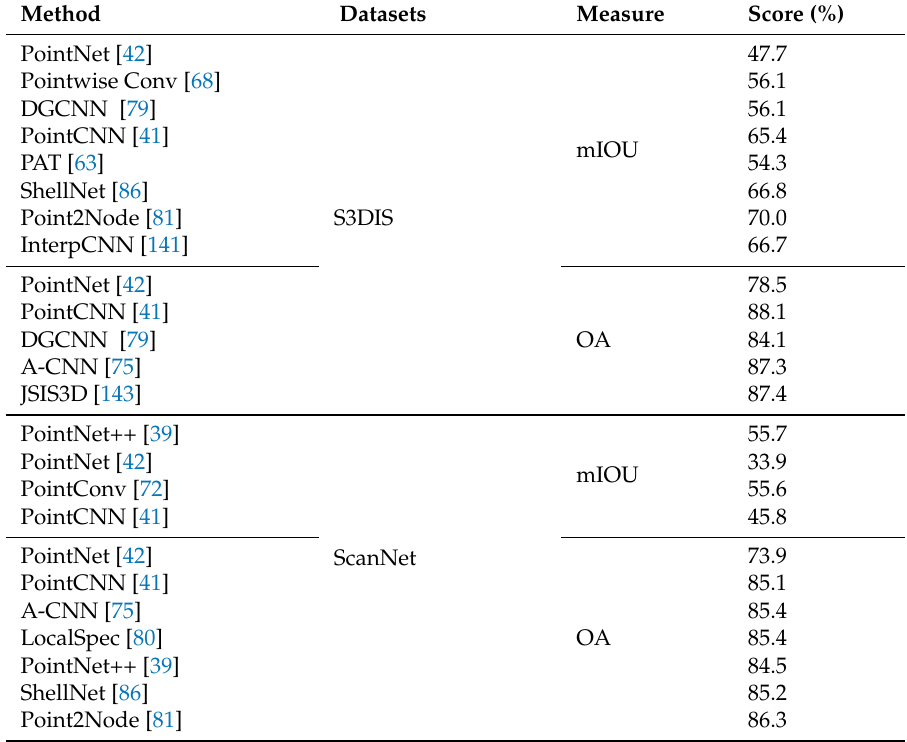
Table 5. Semantic segmentation on S3DIS and ScanNet datasets. OA: overall